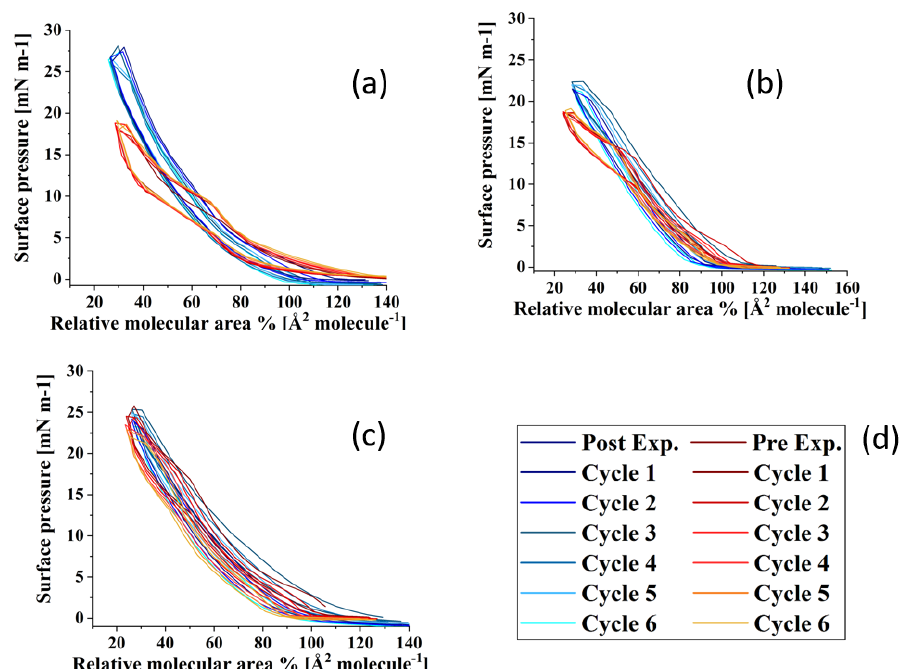
Figure 6. Compression–expansion cycles in terms of relative area of ( a ) CO:PC 90:10 (binary mixture); ( b ) CO:GT:PC 40:40:20 (ternary mixture); and ( c ) CO:GT:FFA:PC 40:25:15:20 (quaternary mixture, bottom) before ozone exposure (( d ), red color family) and after ozone exposure (( d ), blue color family) on PBS at 22 °C.